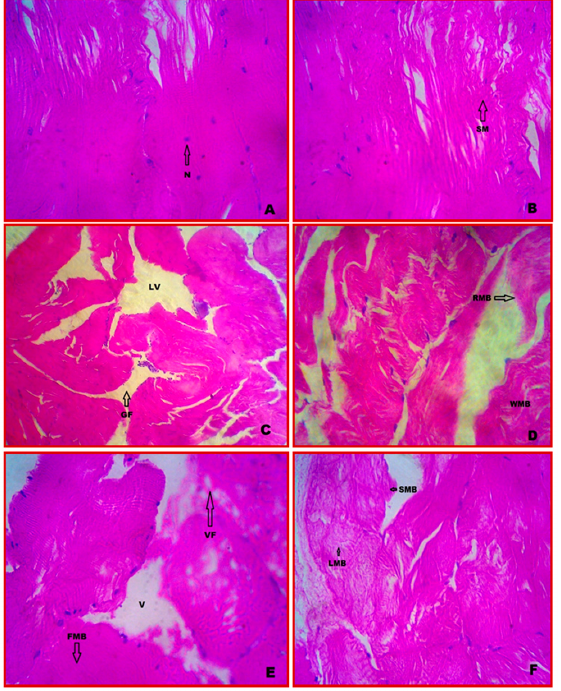
Figure 3. Cytopathological alterations of muscle in E. tetragonum . A paraffin slice stained with hematoxylin and eosin (40×) under the light microscope: ( A , B ) — control, ( C ) — after 7 days of exposure to chlorpyrifos at a dosage of 0.0294 ppm, ( D ) — after 28 days of exposure to chlorpyrifos at a dosage of 0.0294 ppm, ( E ) — after 7 days of exposure to chlorpyrifos at 0.0588 ppm, ( F ) — after 28 days of exposure to 0.0588 ppm chlorpyrifos concentration. Abbreviations used: SM — striated muscle, N — nuclei, LV — large vacuole, GF — gap formation, RMB — rupture of muscle bundle, WMB — wavy